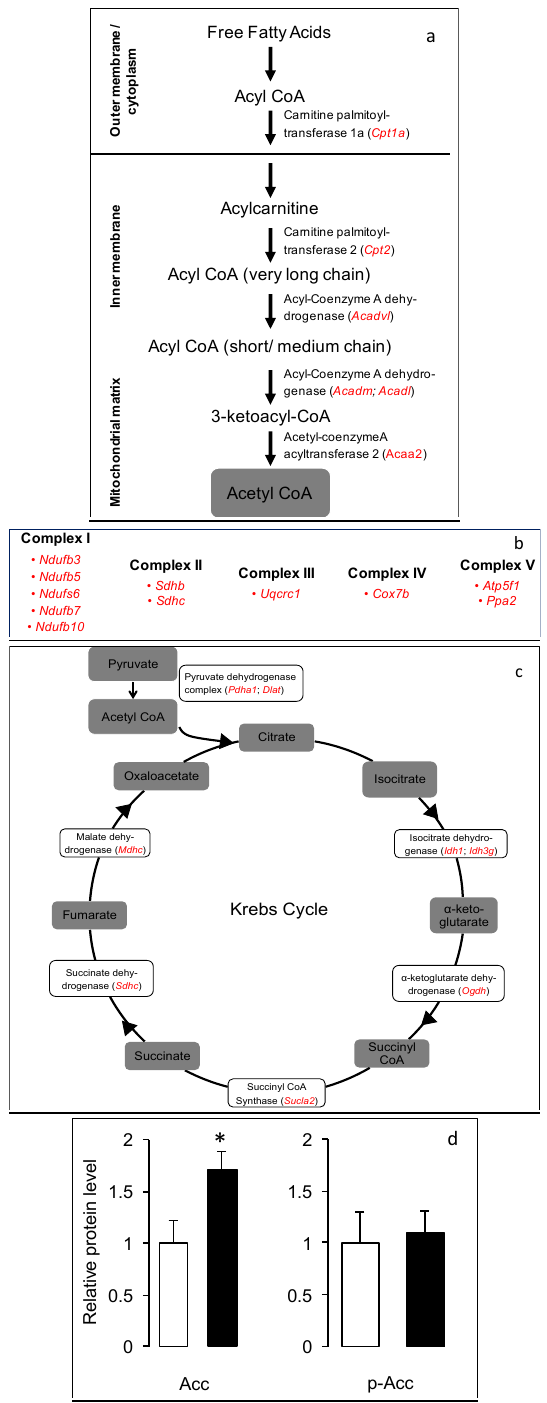
Figure 1. Pathway analysis of the gSkM transcriptome for the comparison of HFD ‐ ED and HFD ‐ corn oil fed mice. The illustration is based on the Kegg pathway database (http://www.genome.jp/kegg/pathway.html). ( a ) Fatty acid β‐ oxidation: Genes highlighted in red are upregulated in gSkM of mice fed HFD ‐ ED compared with HFD ‐ corn oil; ( b ) Electron transport chain: Genes highlighted in red are upregulated in gSkM of mice fed HFD ‐ ED compared with HFD ‐ corn oil; ( c ) Krebs Cycle: Genes highlighted in red are upregulated in gSkM of mice fed HFD ‐ ED compared with HFD ‐ corn oil; ( d ) Relative Acc protein levels in HFD ‐ ED (white bars) fed mice was lower than HFD ‐ corn oil (black bars) and there was no difference in the phosphorylation of Acc (p ‐ Acc) protein after 8 ‐ weeks diet intervention. * Different at p < 0.05.